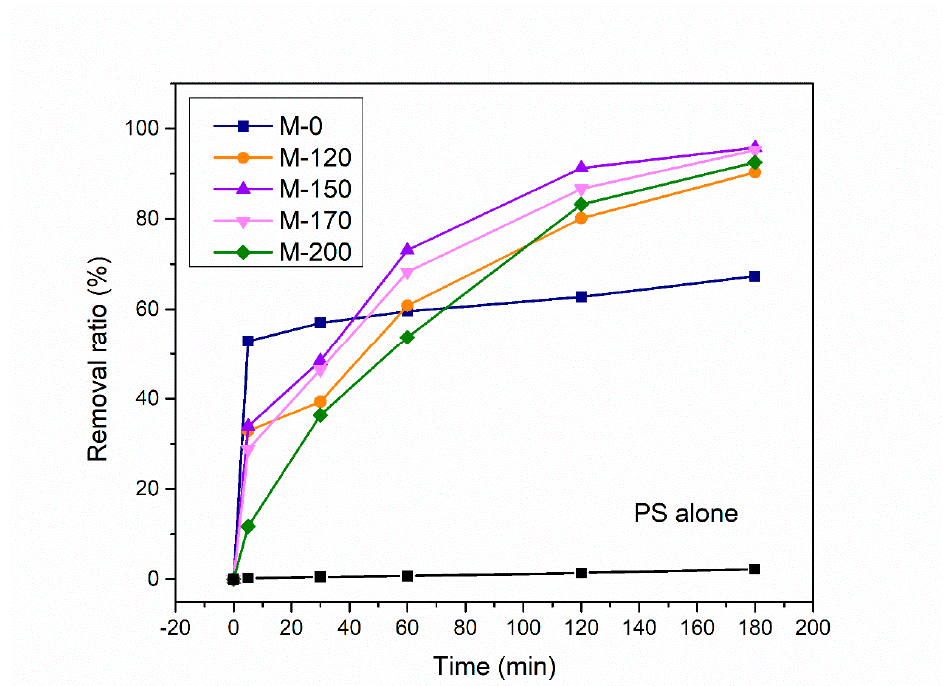
Figure 3. Removal of X-3B under different processes. Experimental conditions: (X-3B) = 100 mg L − 1 , (PS) = 15 mmol L − 1 , catalyst dosage = 0.1 g L − 1 , T = 25 °C .